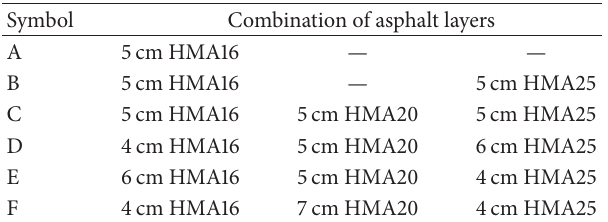
Table 1: Combinations of asphalt layers for multiple factor sensitiv-